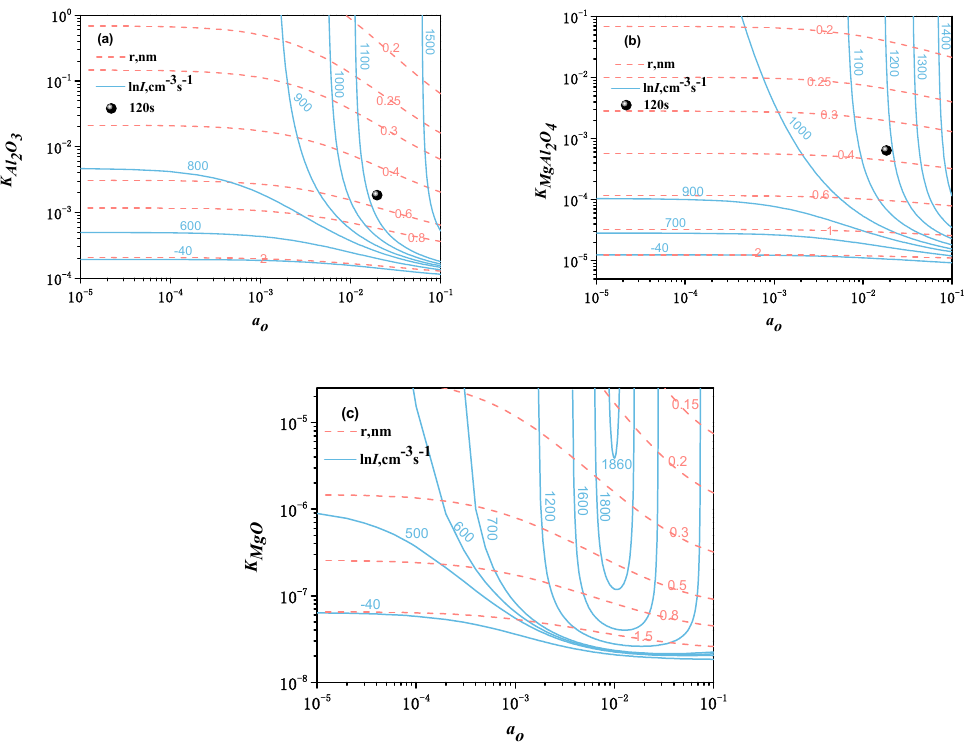
Figure 5. Calculated critical size of nuclei and nucleation rate for oxide inclusions at 1873 K: ( a )Al 2 O 3 , ( b ) MgAl 2 O 4 , ( c ) MgO. Table 4. Parameters used in the calculation of critical size of nuclei and nucleation rate.